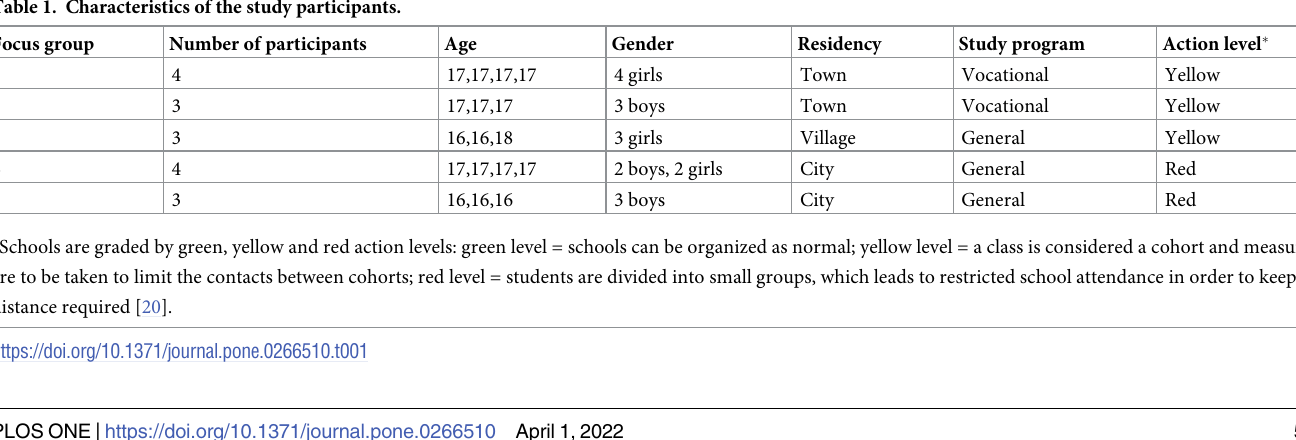
Table 1. Characteristics of the study participants. Focus group